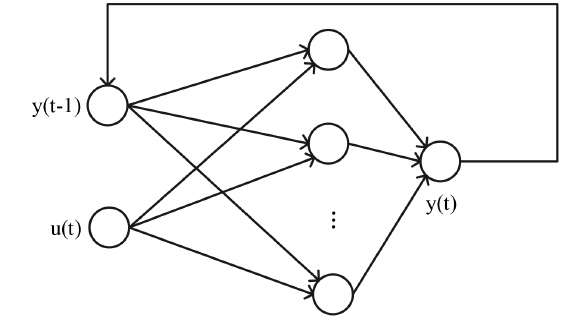
Figure 1. The structure of the NARX model.